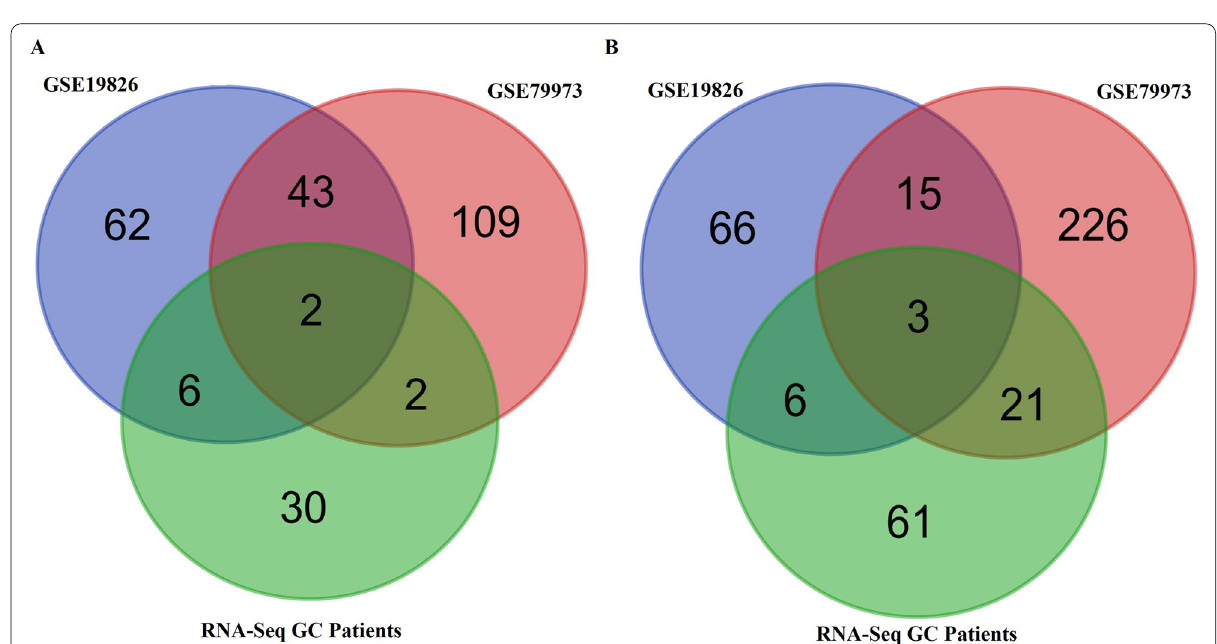
Fig. 2 Comparison of the three datasets. Common genes among A upregulated genes and B downregulated genes. The figures are generated in http:// bioin forma tics. psb. ugent. be/ webto ols/